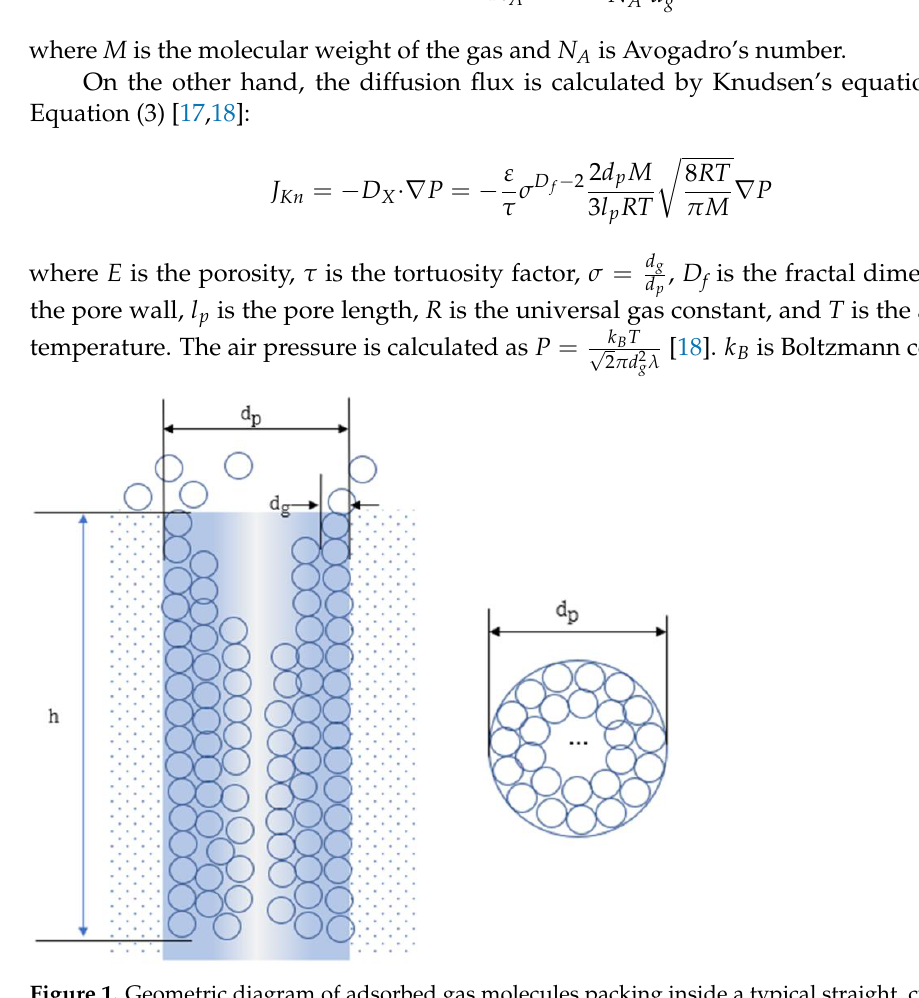
Figure 1. Geometric diagram of adsorbed gas molecules packing inside a typical straight, cylindrical microchannel. d p is the diameter of the pore, d g is the diameter of the gas molecule, h is the length of the pore channel.